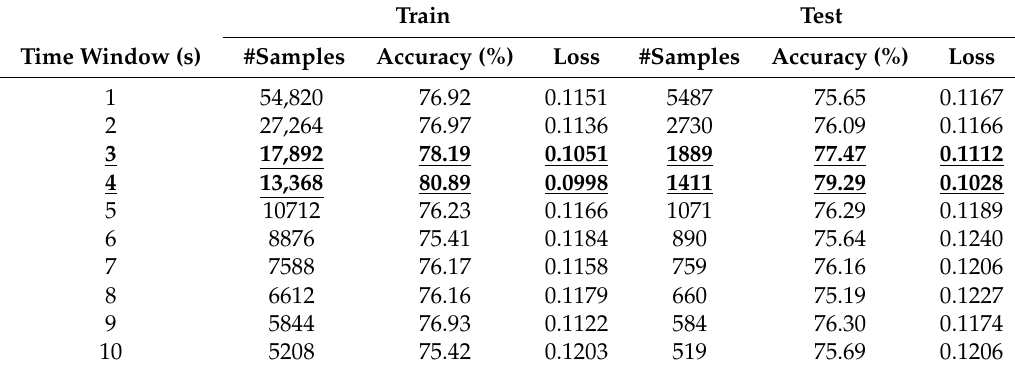
Table 5. Results obtained with ECG network classifying Valence (best time windows are marked). Train Test Time Window (s)